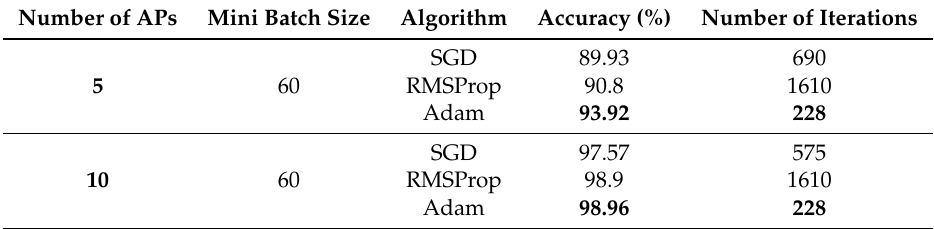
Table 3. Variation of the accuracy according to the optimization algorithm on the validation data using a grid of size 5 m × 5 m.